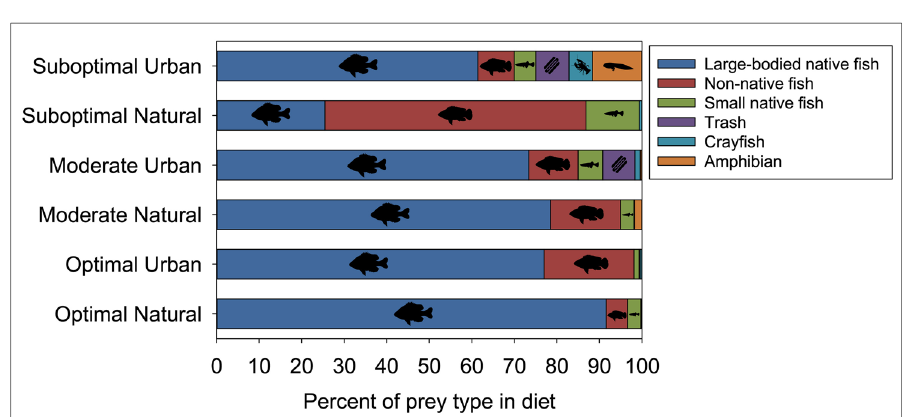
Figure 3. Percent of prey types within stork boluses (n = 643), South Florida, 2015–2017. See Supplementary Table S6 online for species or items that compose each prey